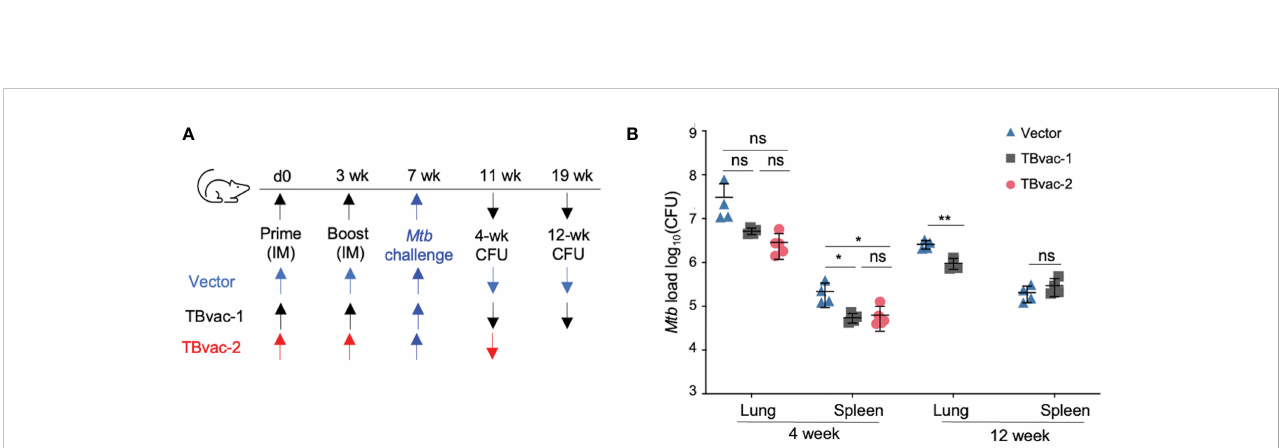
FIGURE 6 TBvac-1 and TBvac-2 reduced bacterial load in mouse lungs in a virulent Mtb infection model. (A) Illustration of the experimental procedure to evaluate the virus-induced protective ef fi cacy in mice. Mice (n=4-5) were immunized (IM) through prime-boost strategy with vector or TBvac-1 or TBvac-2, and, 28 days later, challenged with virulent Mtb . (B) Tissues (lungs and spleens) were collected at 4 and 12 weeks after challenge to determine viable Mtb CFU by plating of tissue homogenates. Statistical analysis was conducted with unpaired t-test. **p < 0.01; *p < 0.05; ns, not signi fi cant.